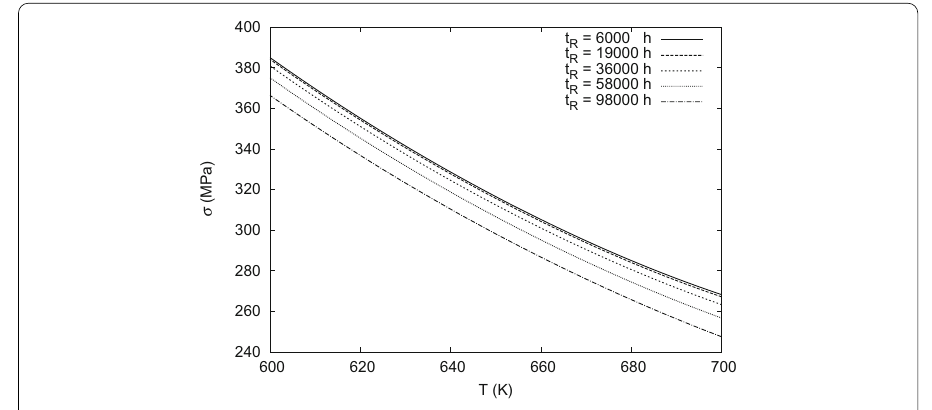
Fig. 13 Predicted “iso- t R ” curves given by the numerical solution of Eqs. (3.42) and (3.43) (see Ref. [61])